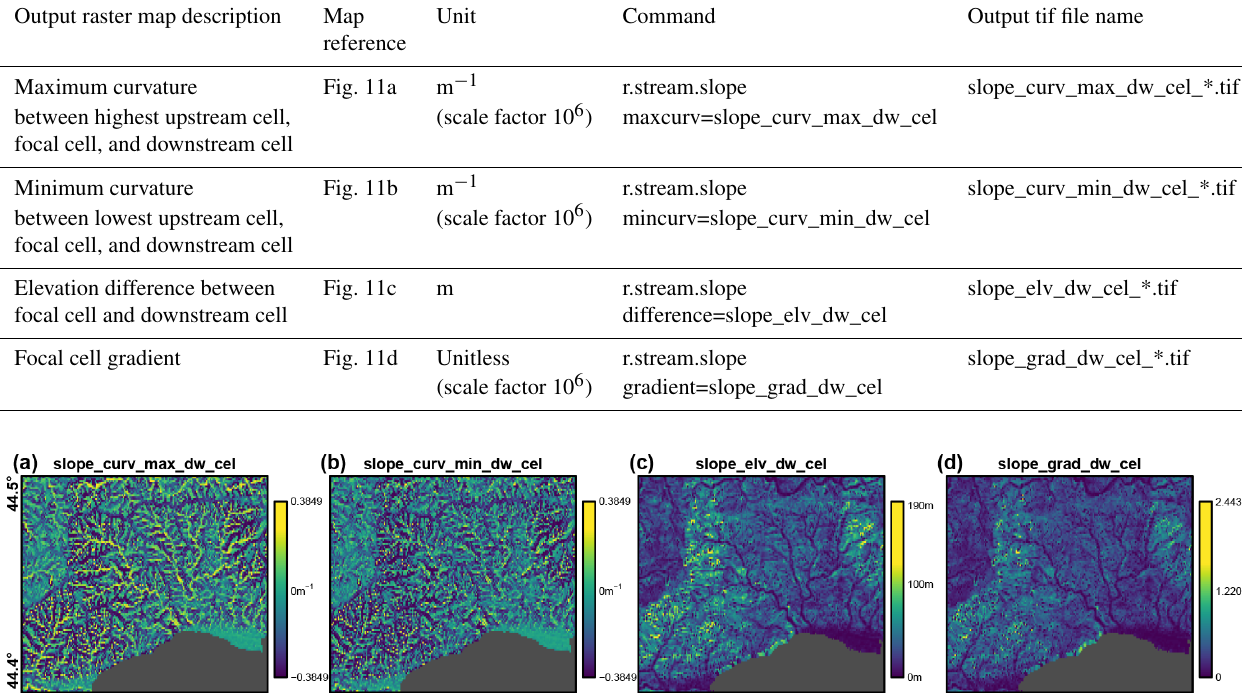
Figure 11. Maps (a) – (b) show curvature and gradient (elevation difference divided by distance) attributes of each land grid cell to the closest cell along the stream channel, computed using the r.stream.slope GRASS GIS module. The panel letters correspond to those in Table